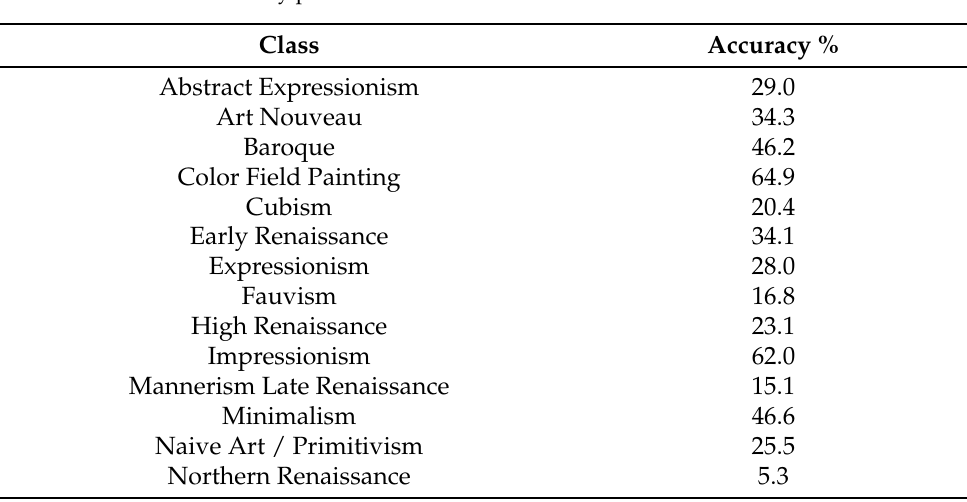
Table 5. MLP Mixer accuracy per